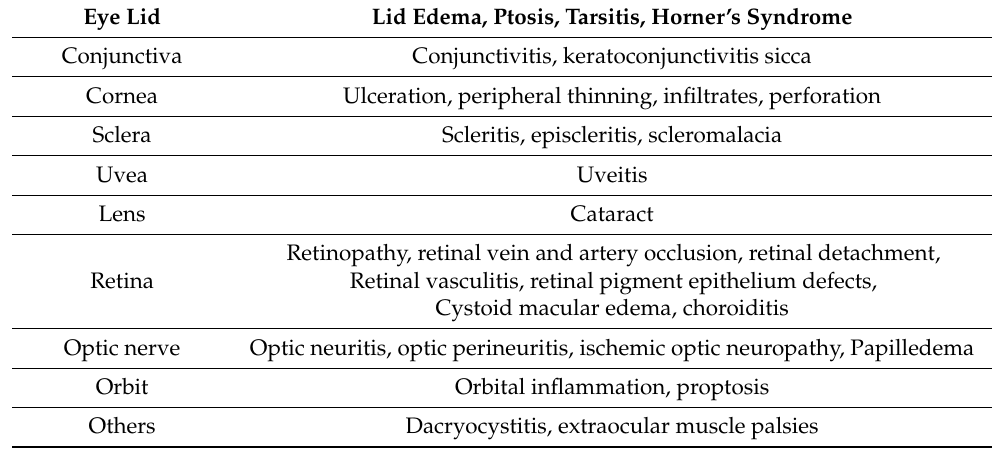
Table 1. Ocular manifestations in patients with RPC.